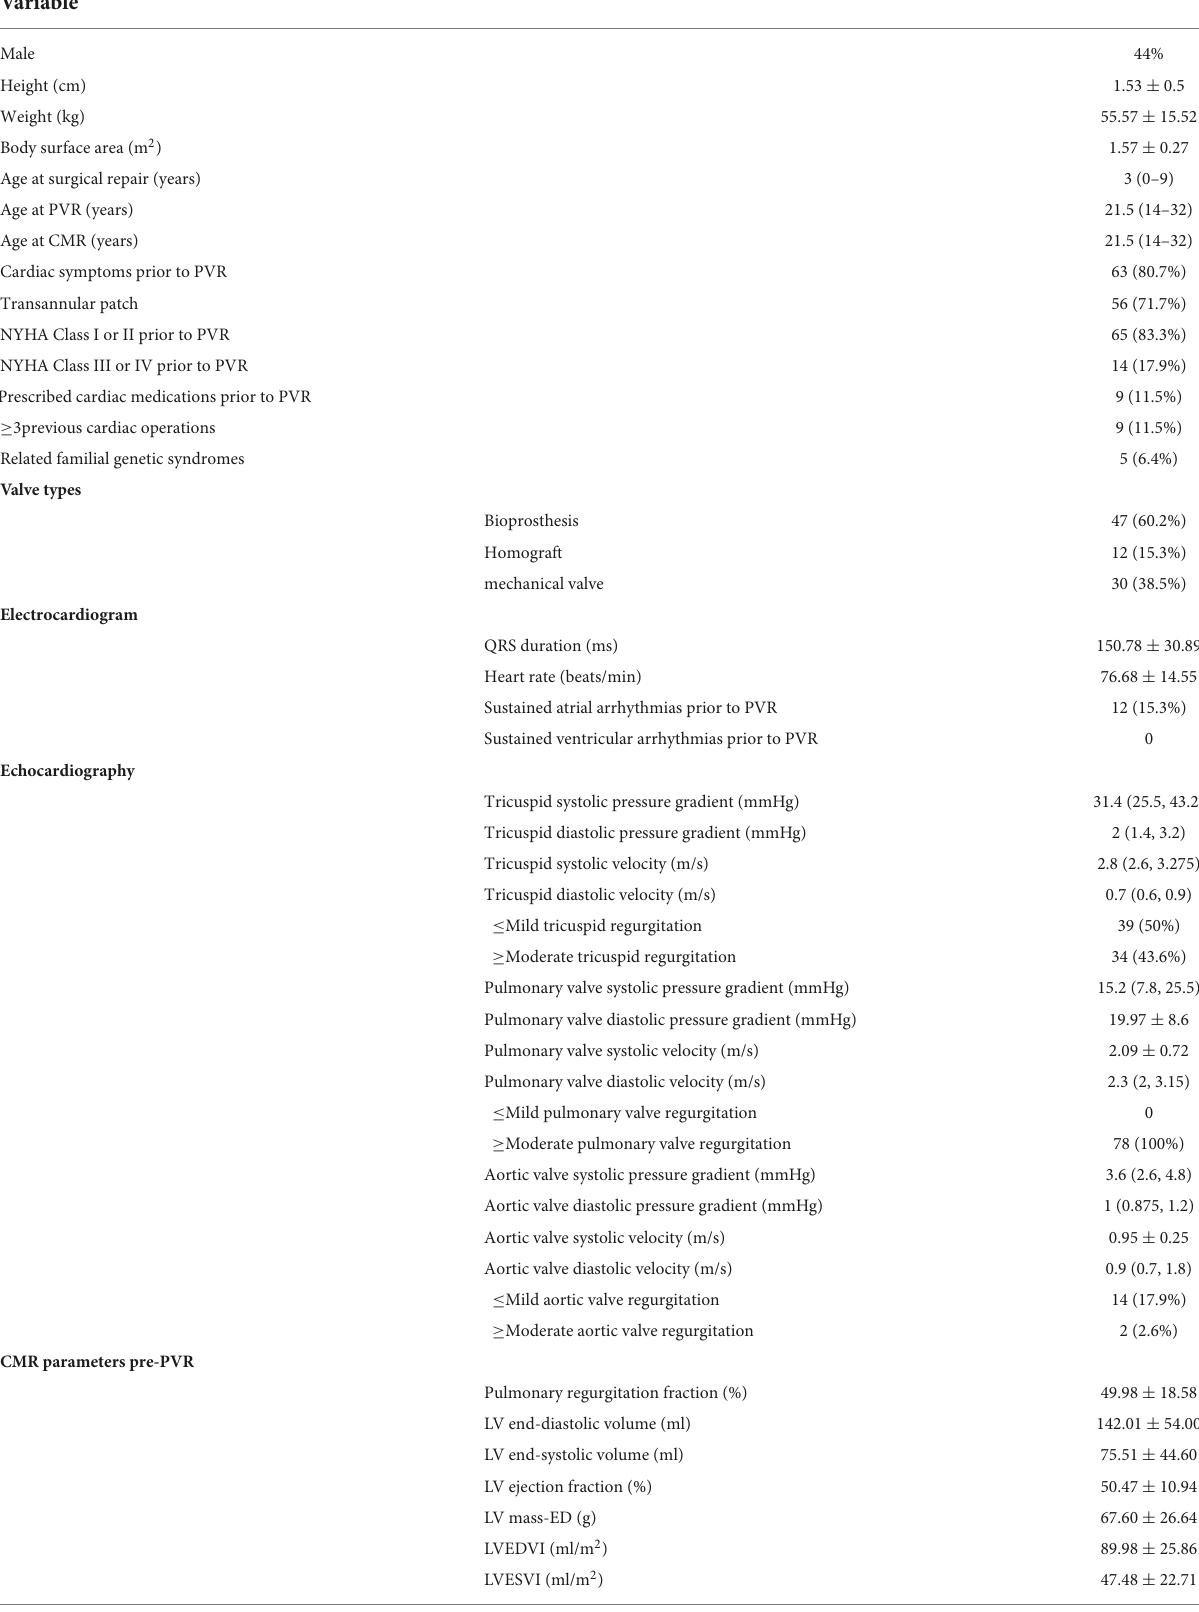
TABLE 1 Baseline demographic, electrocardiographic and CMR parameters of the study subjects ( n = 78).